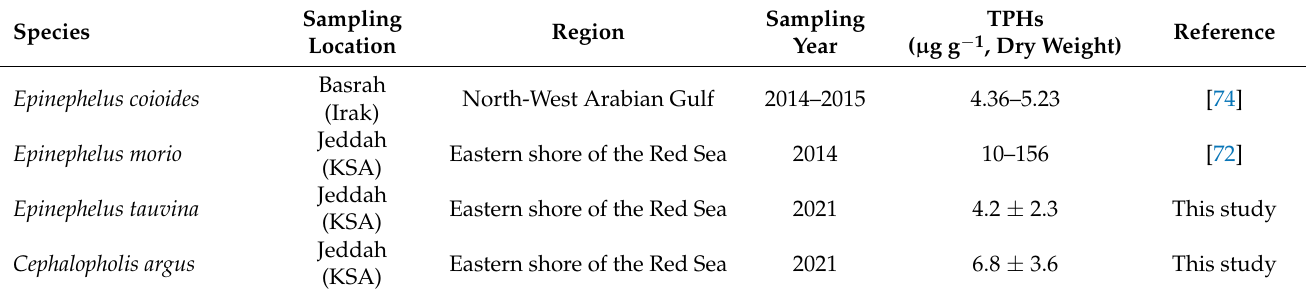
Table 6. Comparison of fish muscle TPHs concentrations in marine biota from Saudi Arabia with other locations in the